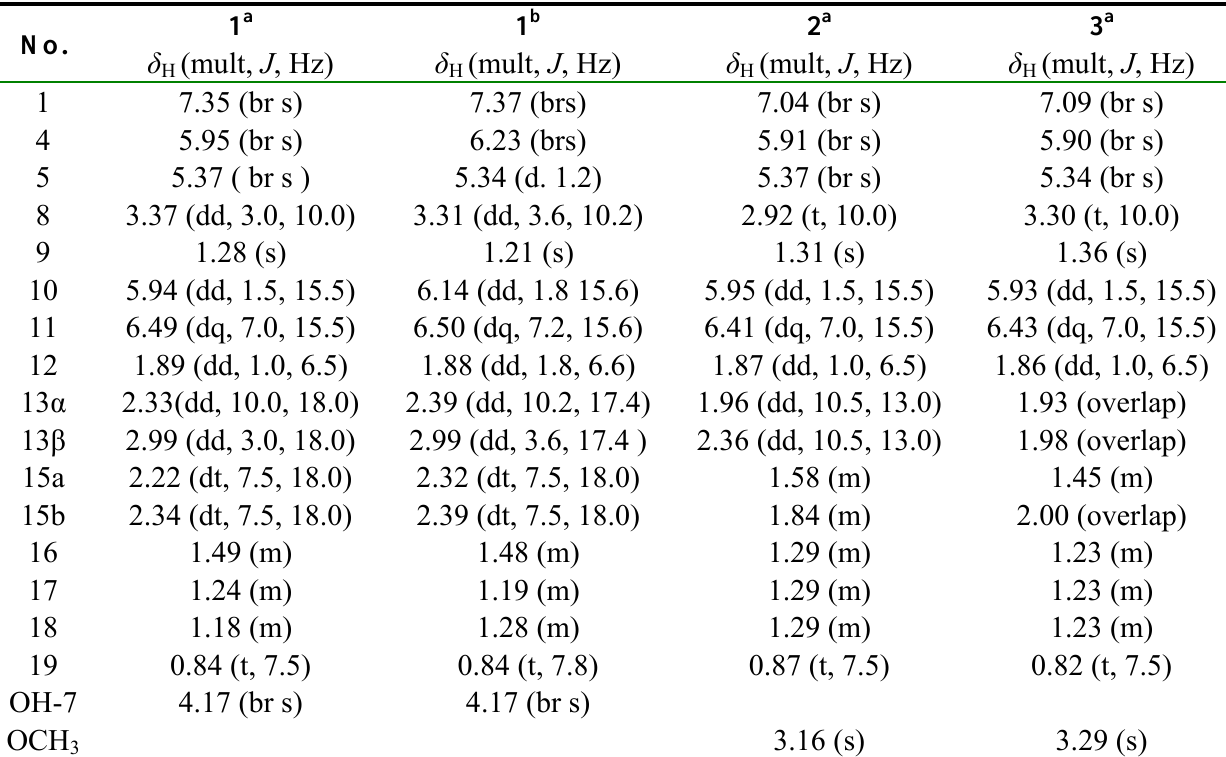
Table 1. 1 H-NMR data for compounds 1 - 3